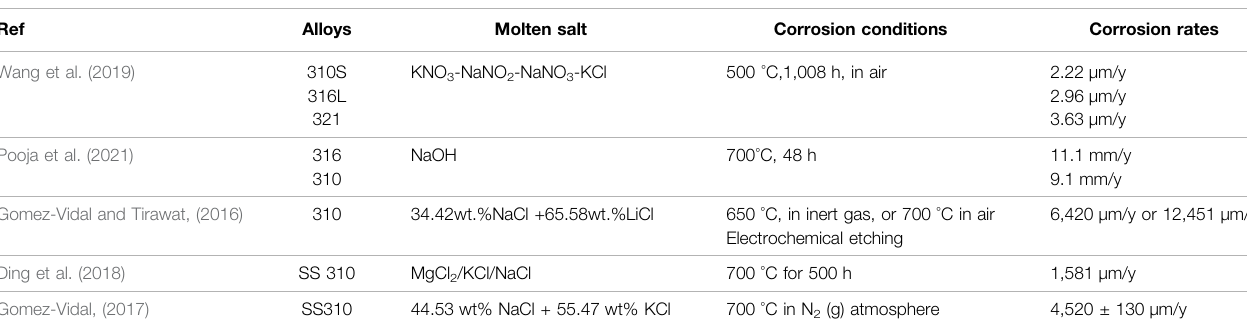
TABLE 2 | Corrosion rates of several stainless steels have been reported in the literature Ref